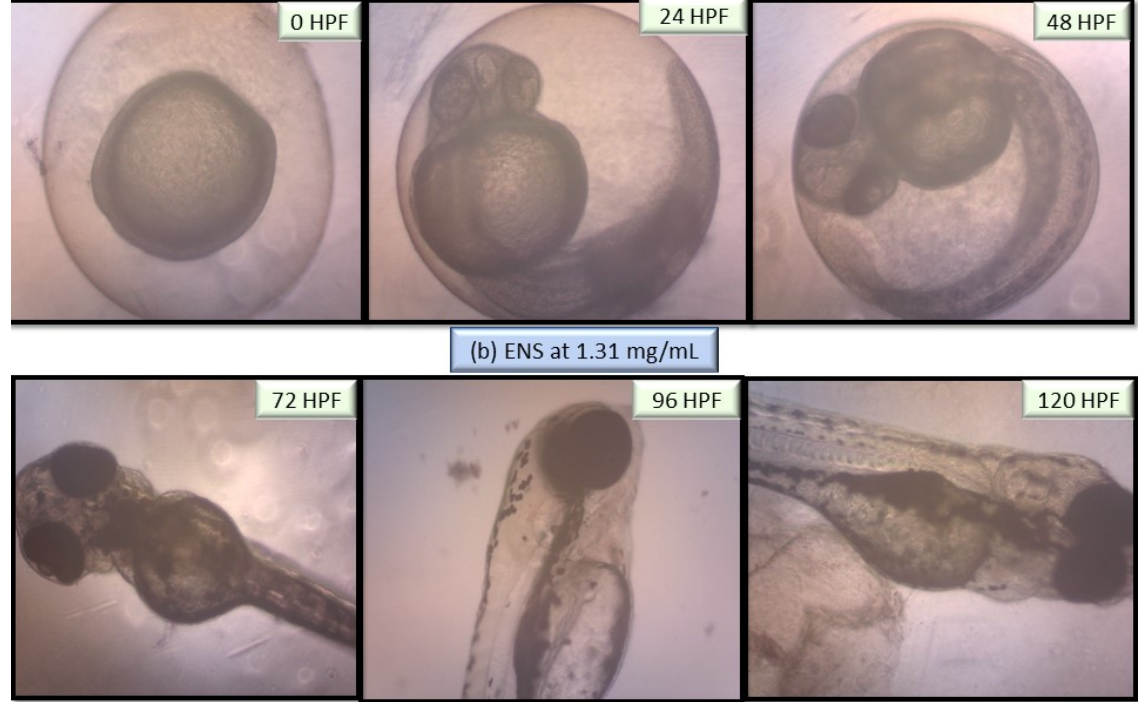
Figure 7. Images of zebrafish embryo and larvae development at 0 HPF, 24 HPF, 48 HPF, 72 HPF, 96 HPF and 120 HPF after treated with European Ganoderma applanatum at high ENS concentration of 1.31 mg/mL. Images were captured using inverted microscope at 100× (0 and 24 HPF) and 40× magnification (48–20 HPF).